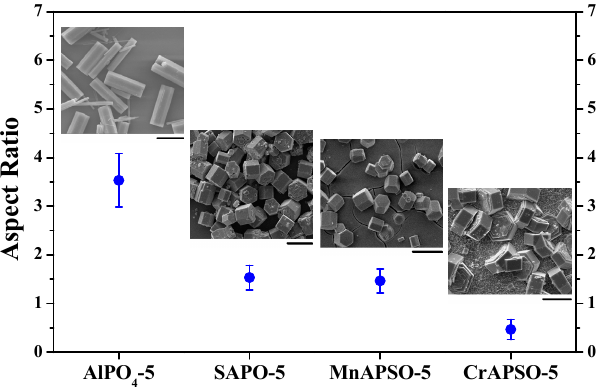
Figure 4. The average aspect ratios together with the corresponding size distributions for AFI molecular sieve crystals with or without heteroatoms. Scale bars correspond to 20- μ m SEM images.